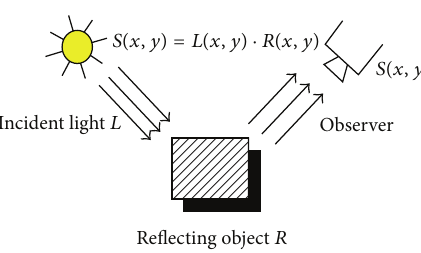
Figure 4: Result image of soft morphology operation.